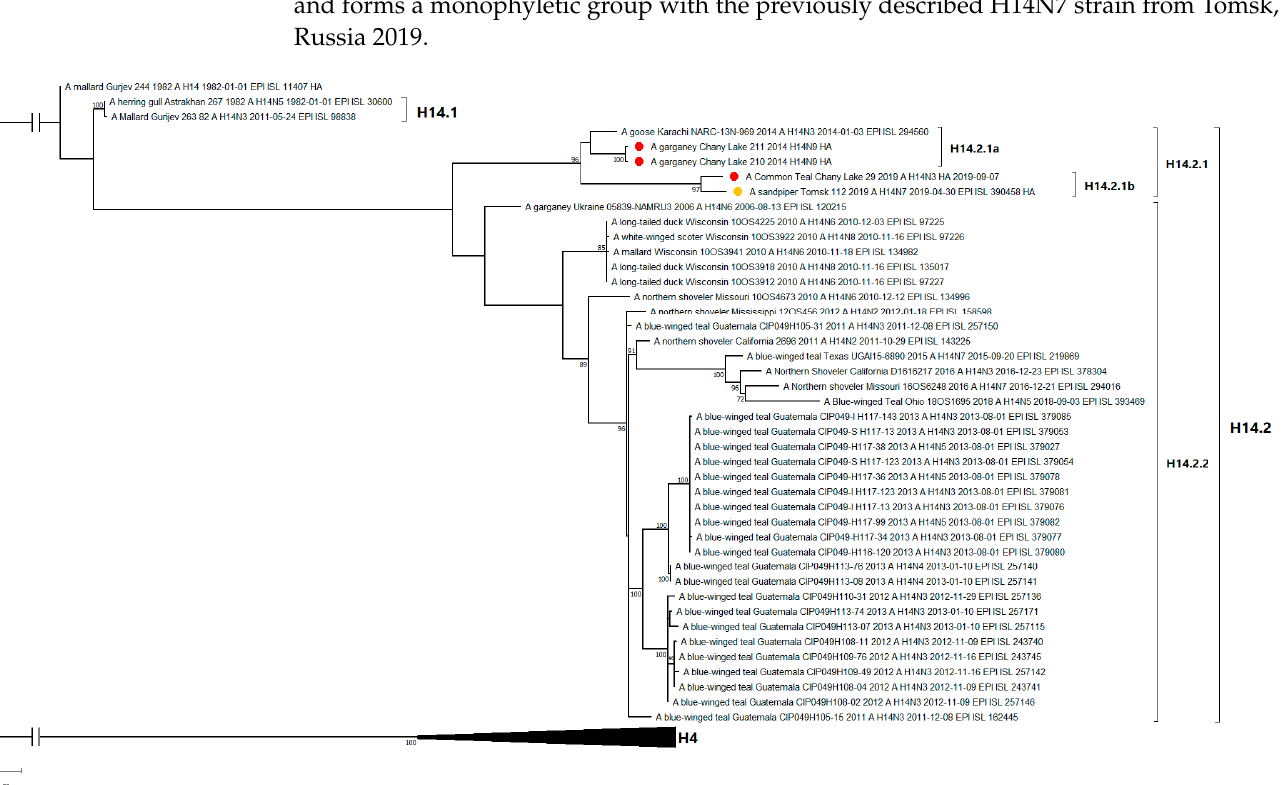
Figure 2. Maximum likelihood phylogenetic tree of HA subtype H14 genome segment of avian influenza viruses ( ● —sequences from this study; ● —sequence of H14 influenza virus strain isolated in related region from public database).